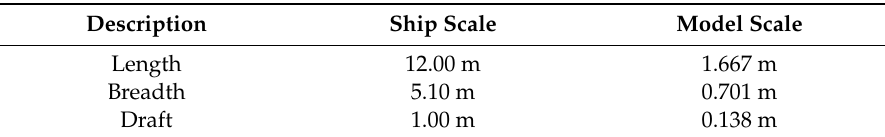
Table 2. Ship Table 2. Ship dimensions.